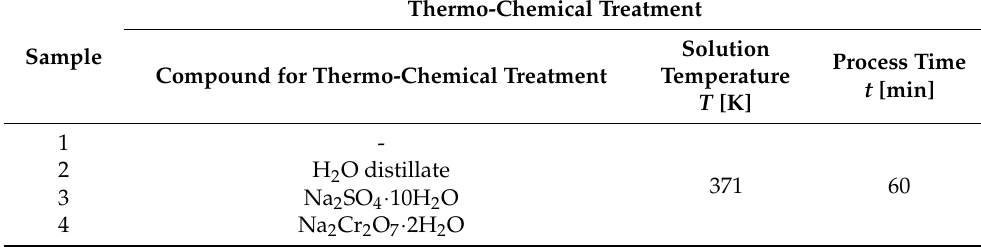
Table 1. Parameters of thermo-chemical